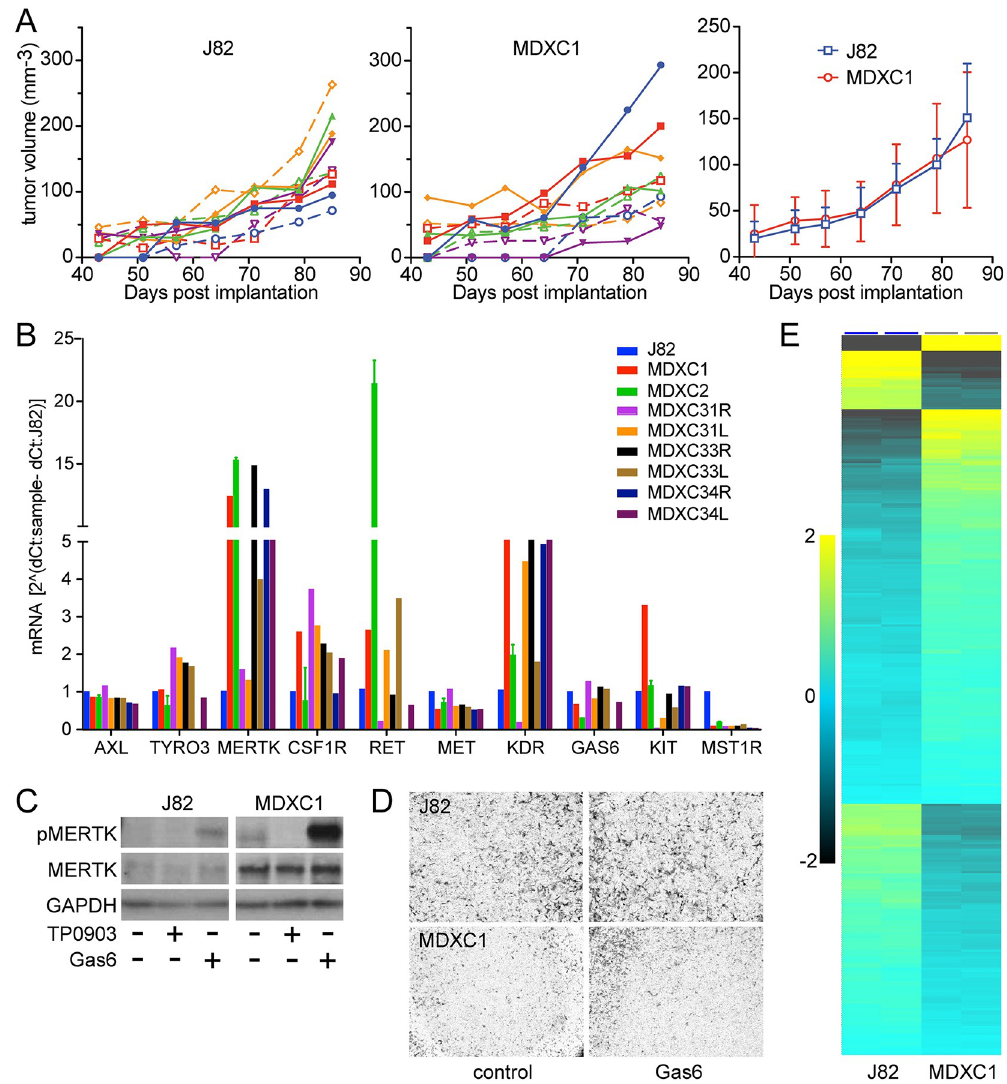
Fig 8. Serial passage of J82 cell xenografts in mice. (A) Tumor volume (mm 3 ) of individual J82 (left) or MDXC1 (middle) cell xenografts in mice, or mean (+/- SD) tumor growth of both cell line xenografts (right), vs. days post implantation. (B) mRNA expression levels of AXL , TYRO3 , MERTK , CSF1R , RET , MET , KDR , GAS6 , KIT and MST1R in J82 cells and 8 J82 tumor-derived cell lines (MDXC1, MDXC2, MDXC31R, MDXC31L, MDXC33R, MDXC33L, MDXC34R and MDXC34L) as determined by qRT-PCR. (C) Immunoblot of lysates from J82 and MDXC1 lysates for phospho-MERTK (pMERTK, upper panels), MERTK (middle panels) or GAPDH (lower panels); intact cells had been treated prior to lysis with Gas6 (5.7 nM) or TP0903 (300 nM) as indicated. Results are representative of 3 or more independent experiments. (D) Light micrographs (10x objective magnification) of stained J82 (upper panels) of MDXC1 (lower panels) 24 h cell migration in the absence (control, left) or presence of added Gas6 (Gas6, 5.7 nM, right). (E) Heat map showing relative mRNA expression levels of 321 genes of the 770 gene Nanostring PanCancer Progression Panel (clustered hierarchically) that were significantly different among untreated J82 (left) and MDXC1 (right) cells (two-group comparison p = 0.021, q = 0.05; S5 Table in S1 File).